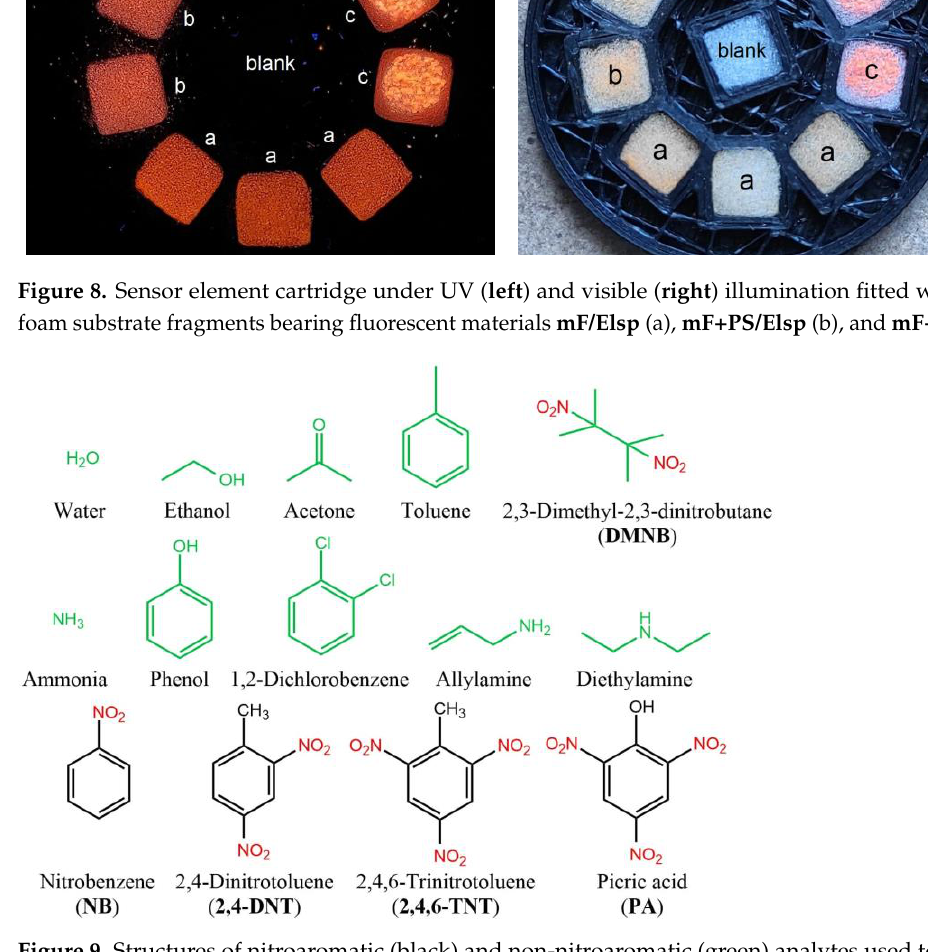
Figure 9. Structures of nitroaromatic (black) and non-nitroaromatic (green) analytes used to study fluorescent response of obtained materials versus vapor phase analytes.